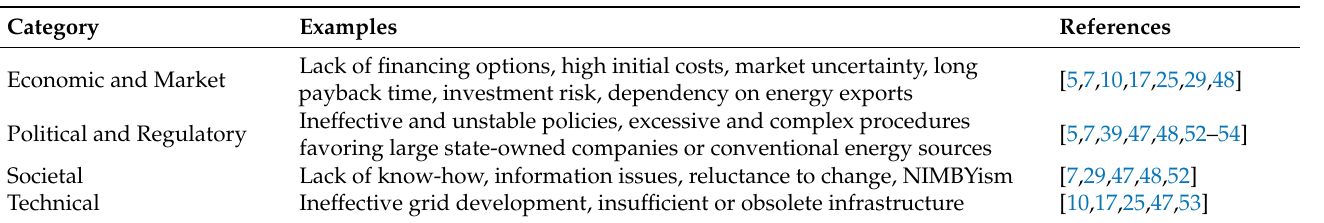
Table 3. Categories of RET barriers in Finland and